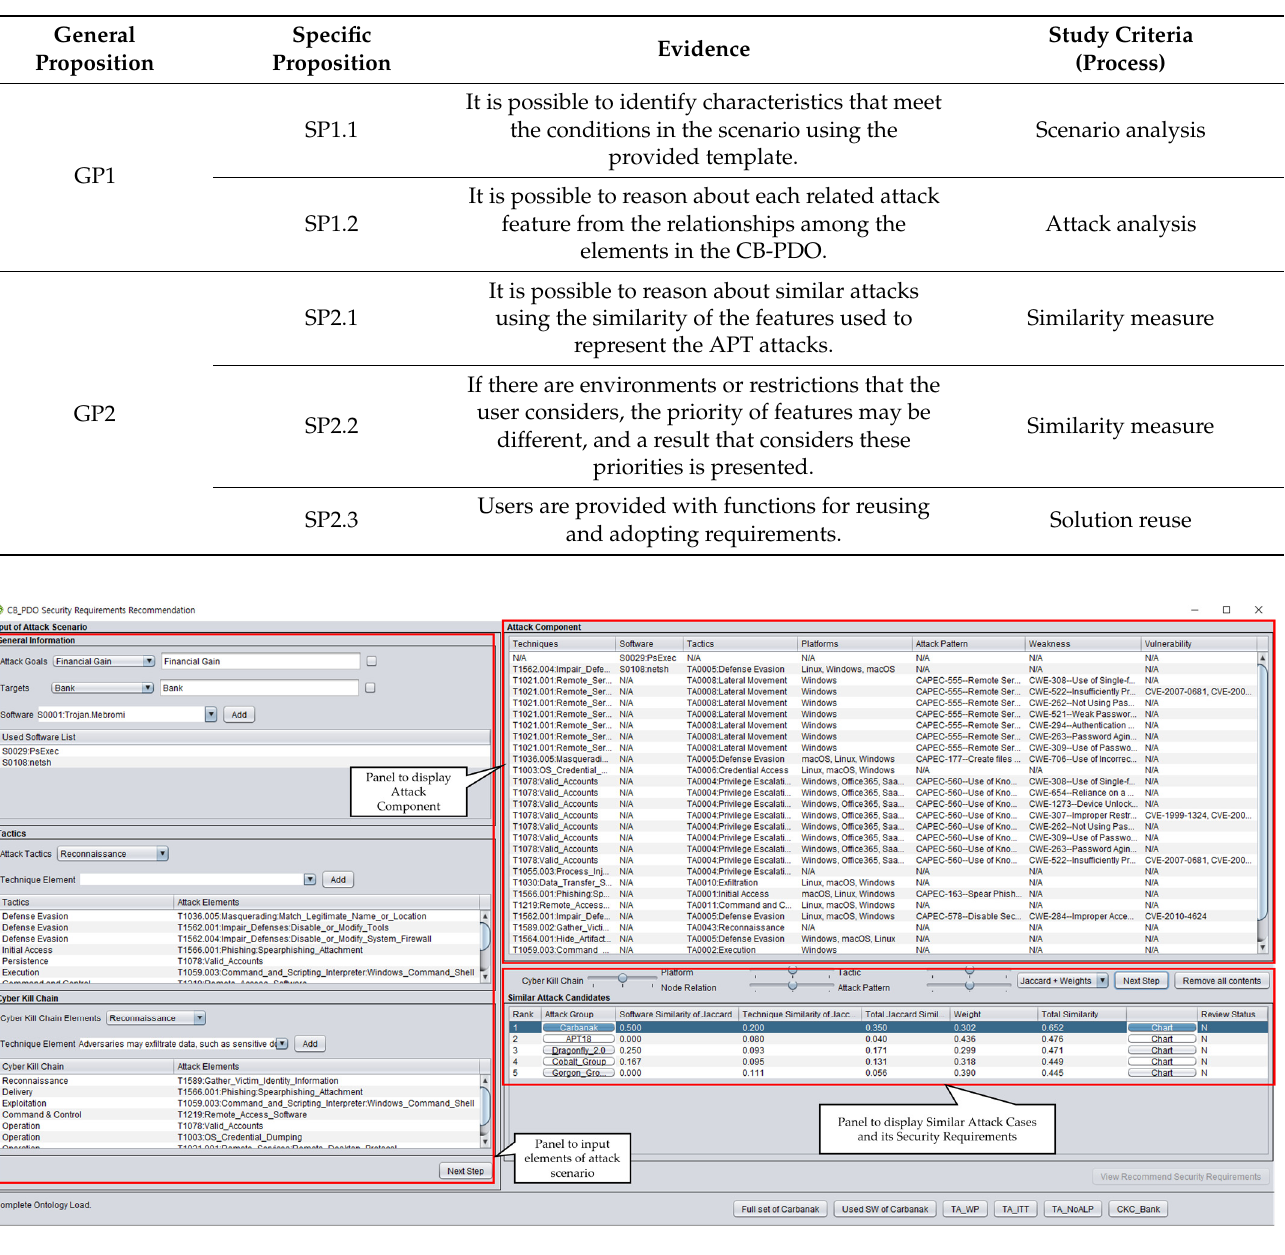
Figure 7. Initial screen of the prototype.